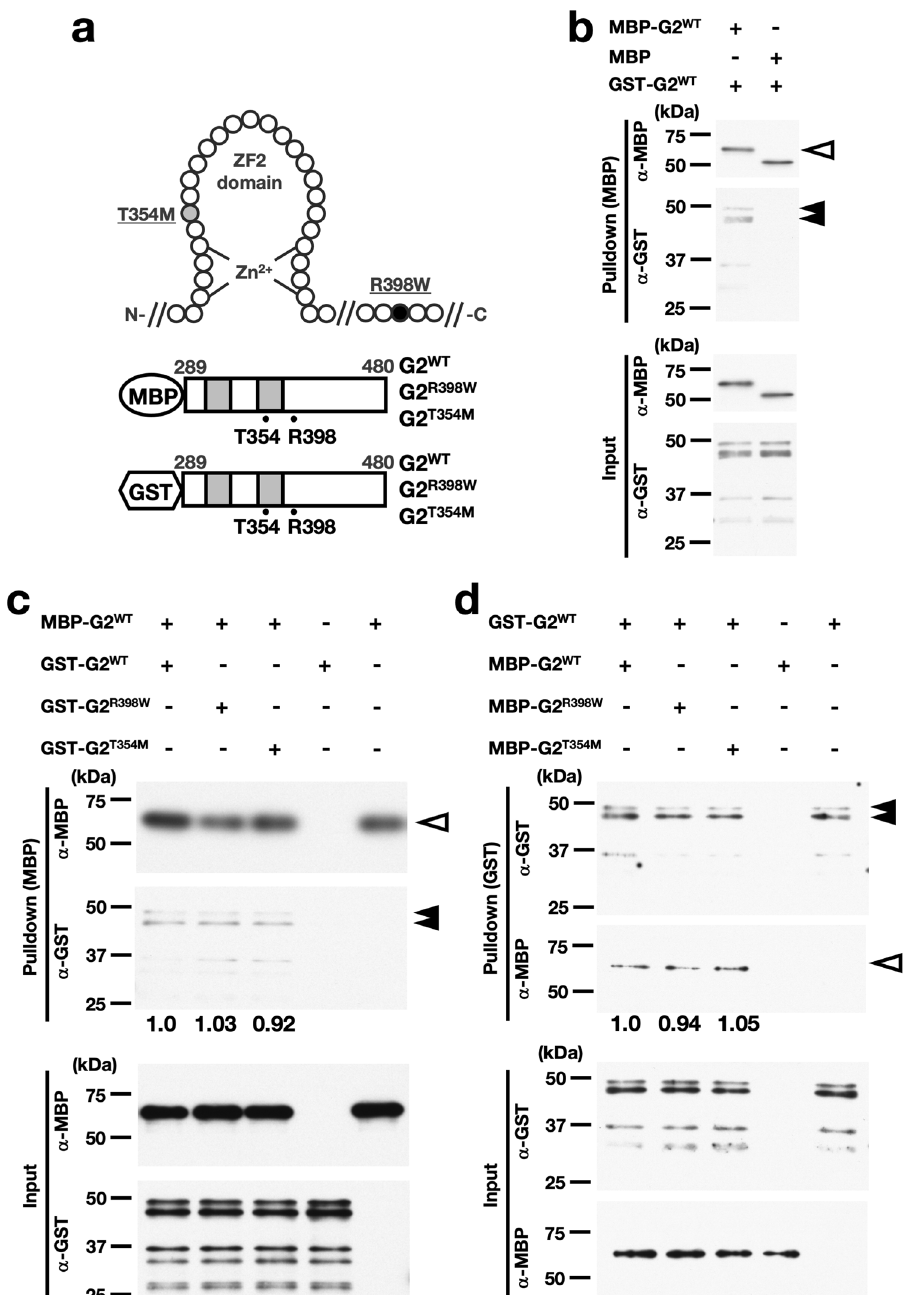
Fig. 6 G2 WT forms dimers with G2 R398W and G2 T354M as well as with G2 WT . a Schematic illustration of recombinant MBP-fused and GST-fused GATA2 proteins and the positions of the substituted amino acids. b – d Pull-down assays of MBP-fused ( b , c ) and GST-fused ( d ) GATA2. The indicated recombinant proteins were mixed. MBP- and GST-fused GATA2 were detected by the corresponding antibodies. White and black arrowheads indicate the pull-down signals of MBP-fused and GST-fused GATA2, respectively. Quanti fi cation of band intensities in Western blots was performed by the ratio of the GST ( c ) or MBP ( d ) pull-down signal to the input signal. The value in the left-most lane was set to 1.0. Experiments were performed in duplicate, and the results were